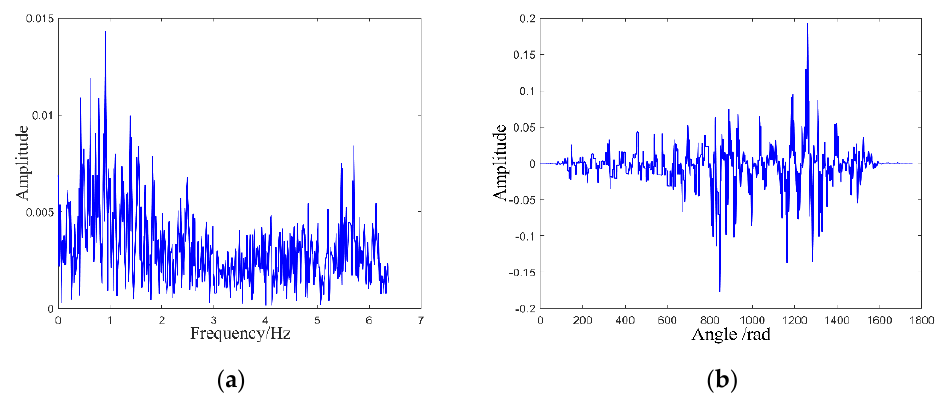
Figure 9. ( a ) The spectrum of the original non-stationary signal; ( b ) the stationary signal after angular domain transformation.